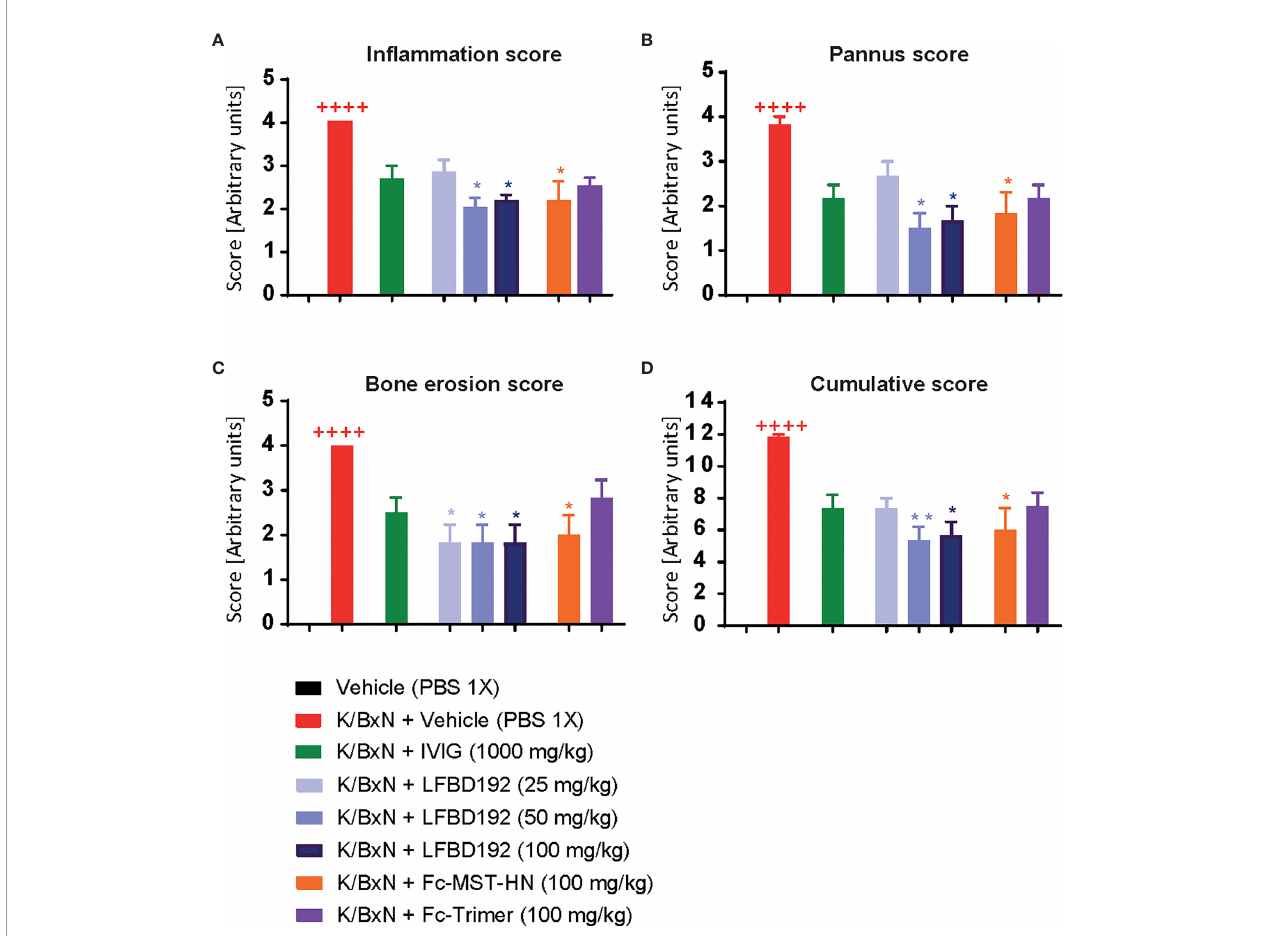
FIGURE 8 | LFBD192 ameliorates histological scores in a K/BxN mouse model. Effect of compounds IVIg (2000mg/kg), LFBD192 (25, 50 and 100mg/kg), Fc-MST- HN (100mg/kg) and Fc-trimer (100mg/kg) on histological scores. On day 10, mice were killed, and ankle joints were harvested and fi xed in 10% paraformaldehyde and decalci fi ed for 10 days. Paraf fi n embedded sections were stained with hematoxylin & eosin (H&E) and scanned under a microscope. Histologic scoring including in fl ammation (A) , bone erosion (B) , pannus (C) , and cumulative scores (D) are shown. The sections were graded using various parameters, as follows: severity of synovial hyperplasia (pannus formation), cellular exudates (in fl ammation), and cartilage depletion/bone erosion, each scored 0 [normal] to 5 [severe], and extent of synovial in fi ltrate, scored 0 – 5, with higher scores indicating greater in fi ltration. The grades for all parameters were subsequently summed to obtain the cumulative score. Quantitative data show mean and SEM from six animals per group from three independent experiments. Statistical analysis: Non parametric Kruskal-Wallis test followed by a Dunn ’ s multiple comparisons test ++++ p <0.0001, Vehicle compared with K/BxN + Vehicle; * p <0.05, ** p <0.01, K/BxN + Vehicle compared with